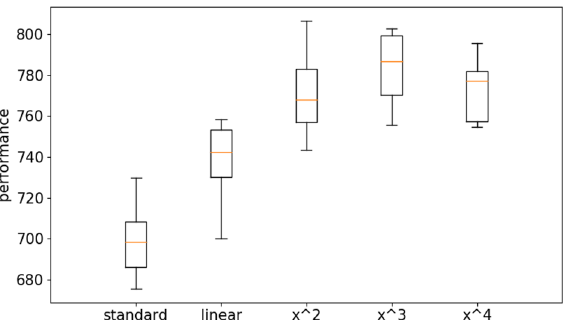
Figure 4. Performance of the agents evolved with the OpenAI-ES algorithm on the double pole balancing problem with the standard and with the curriculum learning version of the algorithm. For the latter case the figure reports the results obtained by using a linear difficulty function (linear) and a power function with exponential 2, 3 and 4 (x 2 , x 3 , and x 4 ). Each boxplot shows the results obtained in 10 replications. Boxes represent the inter-quartile range of the data and horizontal lines inside the boxes mark the median values. The whiskers extend to the most extreme data points within 1.5 times the inter-quartile range from the box.